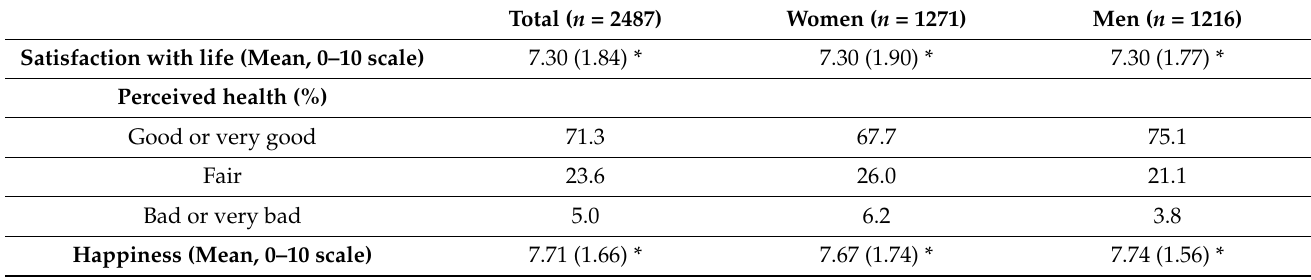
Table 2. Dependent variables: Satisfaction with life, perceived health and happiness.